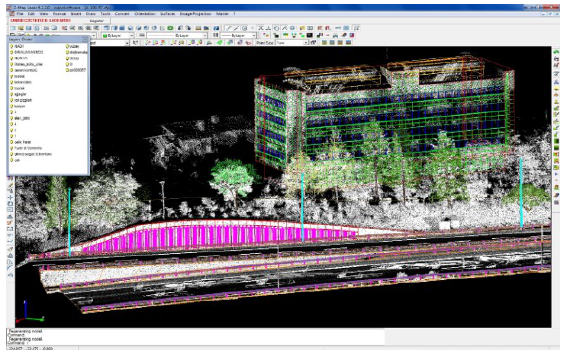
Figure 16: The backpack